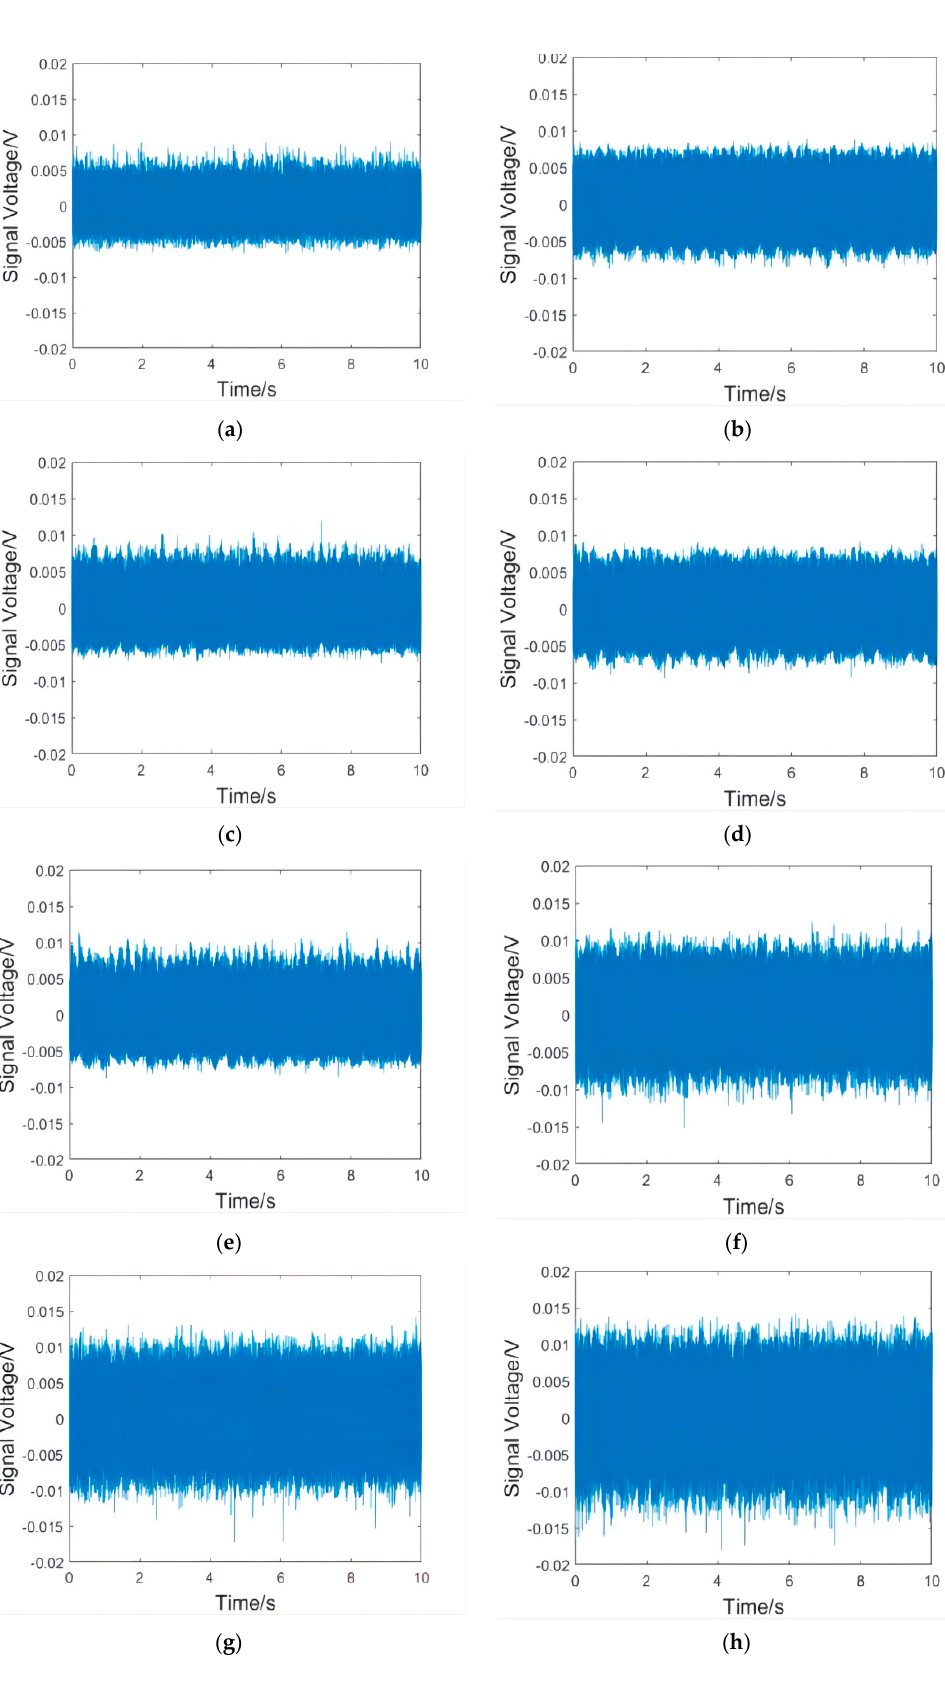
Figure 8. Vibration waveform in the X direction of the workpiece at 8000 rpm. ( a ) After the initial clamping; and after ( b ) 1000, ( c ) 1500, ( d ) 2000, ( e ) 2500, ( f ) 3000, ( g ) 3500, and ( h ) 4000 clamping repetitions.